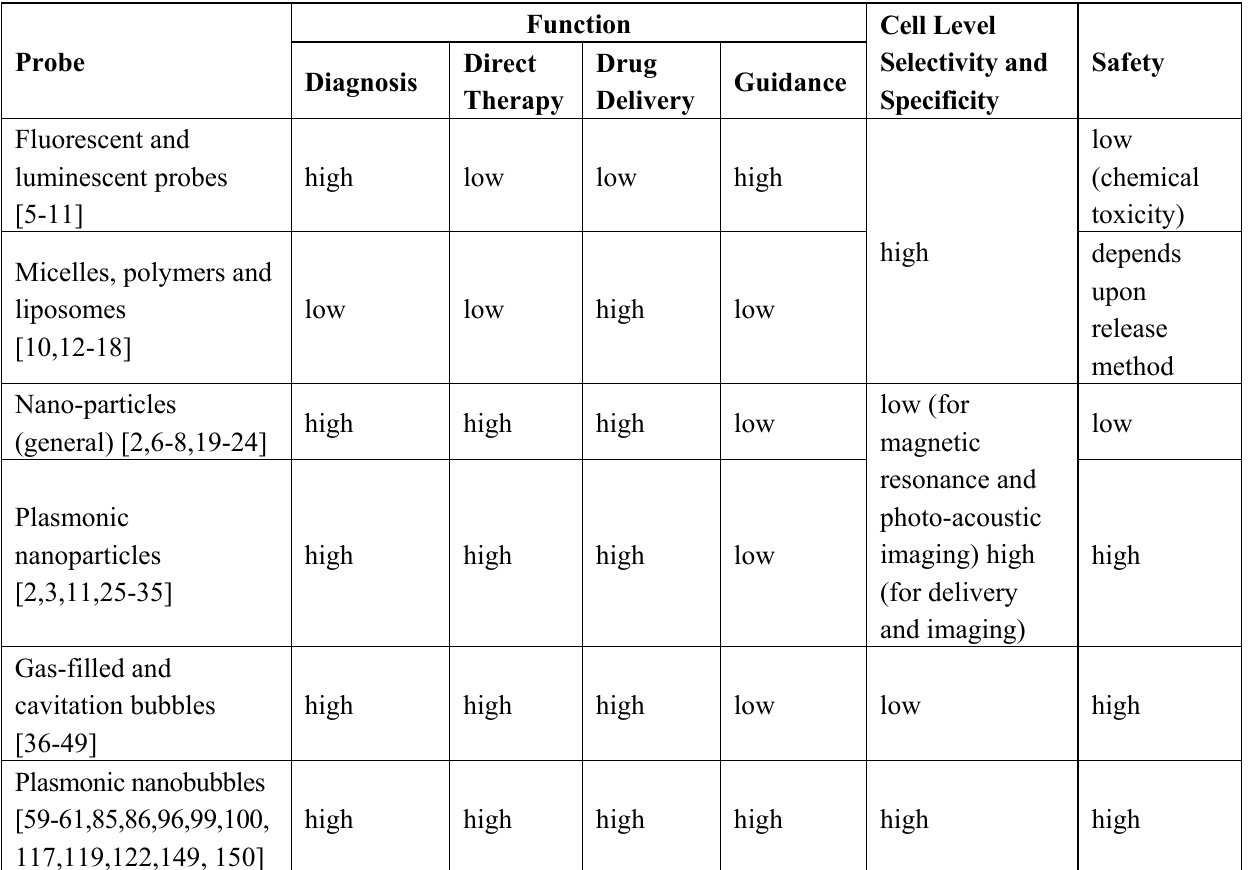
Table 5. Comparison of the theranostic functions of the existing cellular probes and plasmonic nanobubbles (high—very efficient, low—not